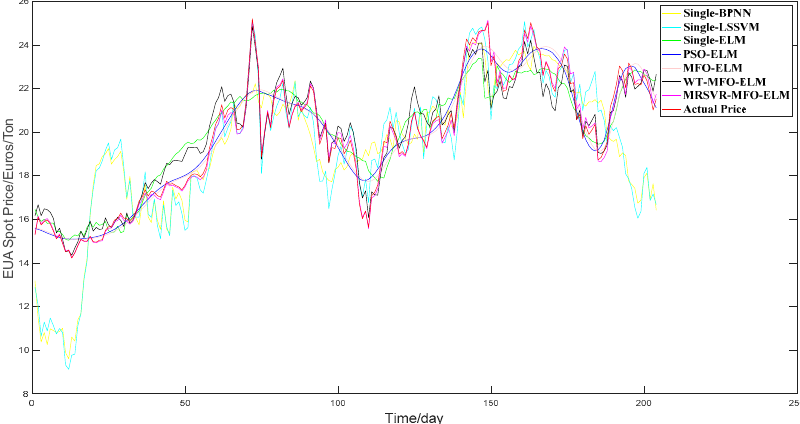
Figure 12. The fitting curves of seven models for EUA spot price forecasting.